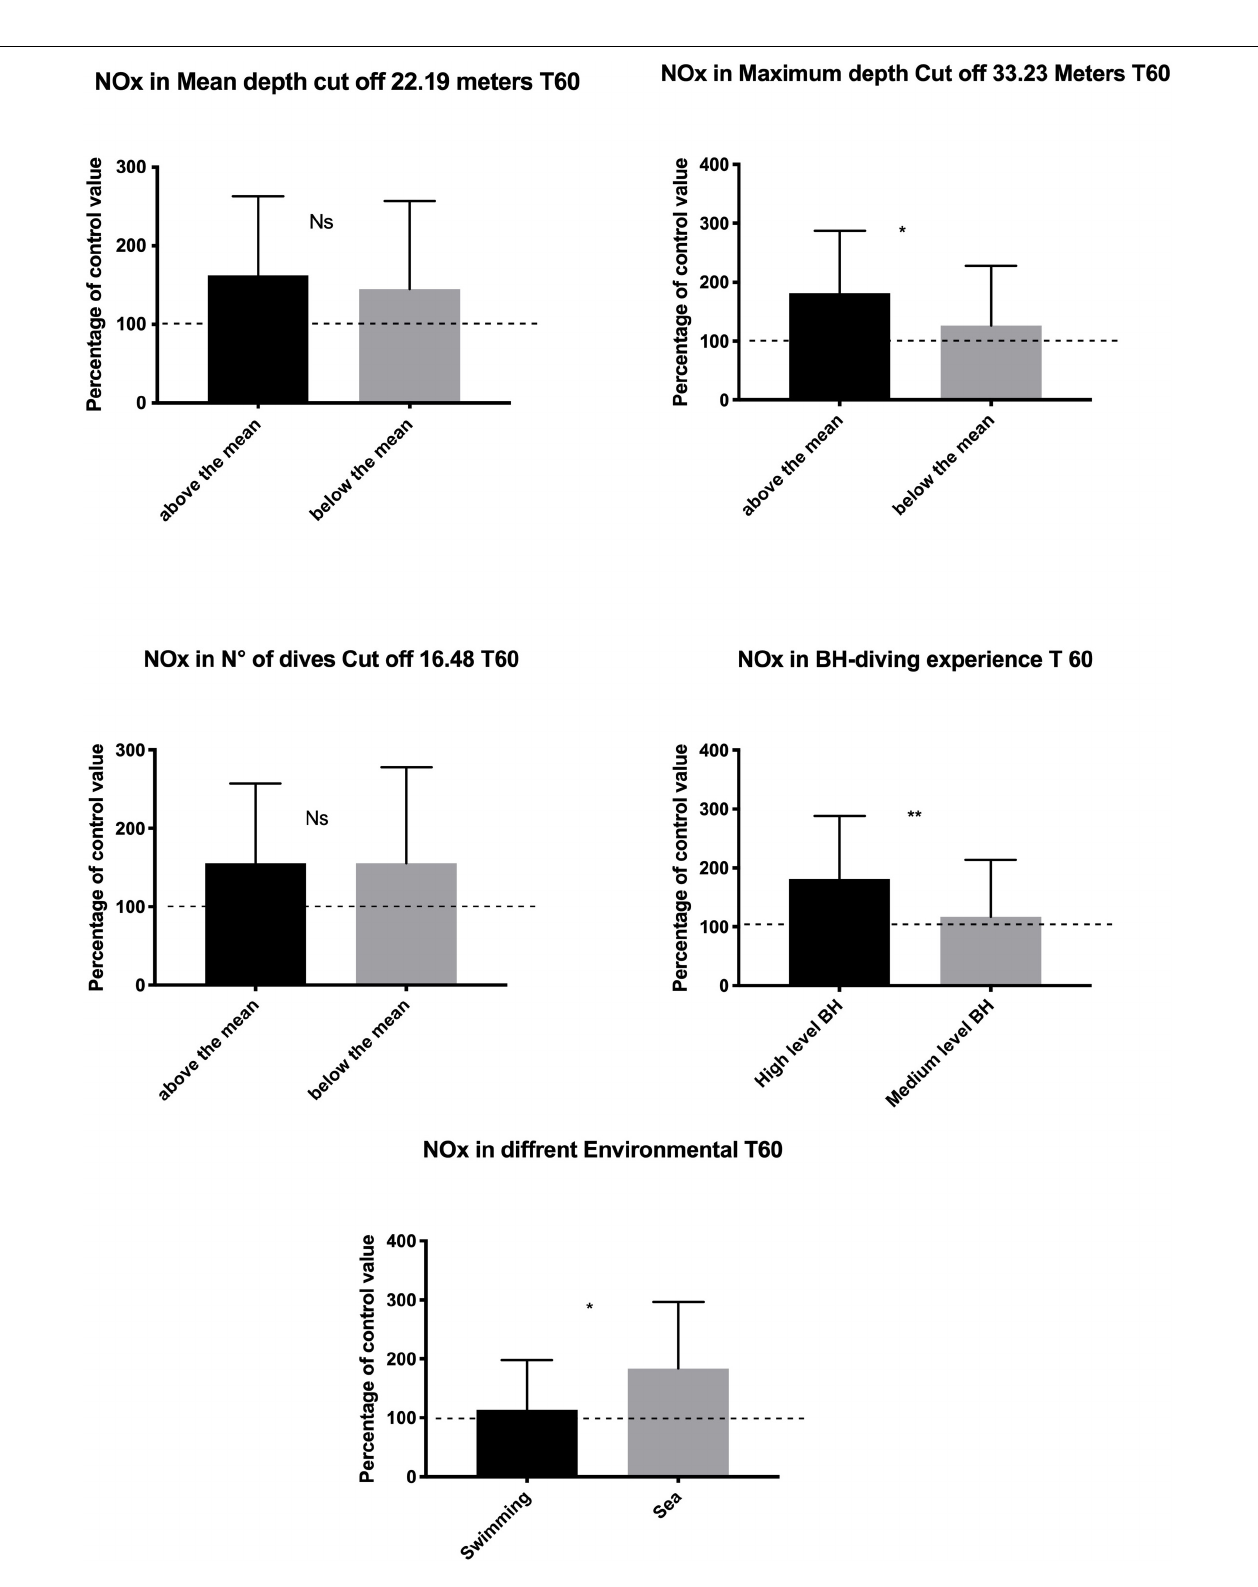
FIGURE 3 | Data at T60 show a rebound effect with an increase of NO available probably to compensate for the higher underwater consumption. This rebound effect was larger in the subject who shows a higher diving exposure and experience and in sea diving as compared with the swimming pool diving. * p < 0.05, ** p < 0.01.